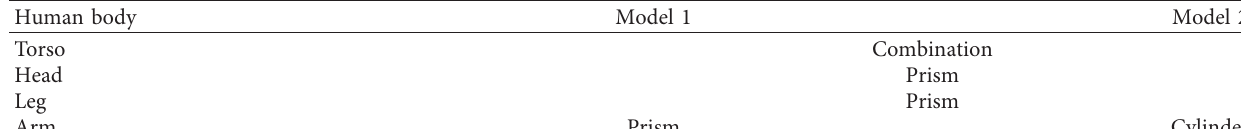
Table 11: Human body models with various arm